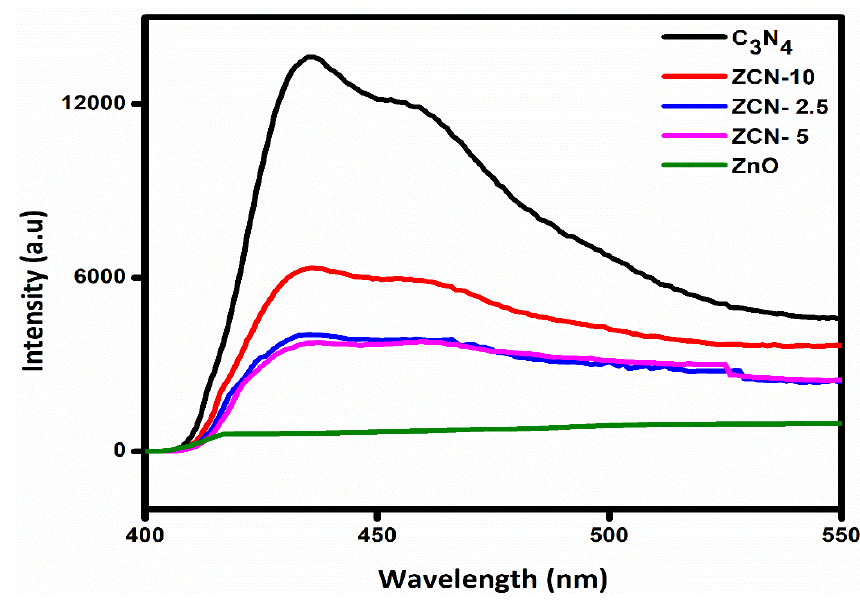
Figure 4. PL spectra of composites of ZnO/C 3 N 4 .